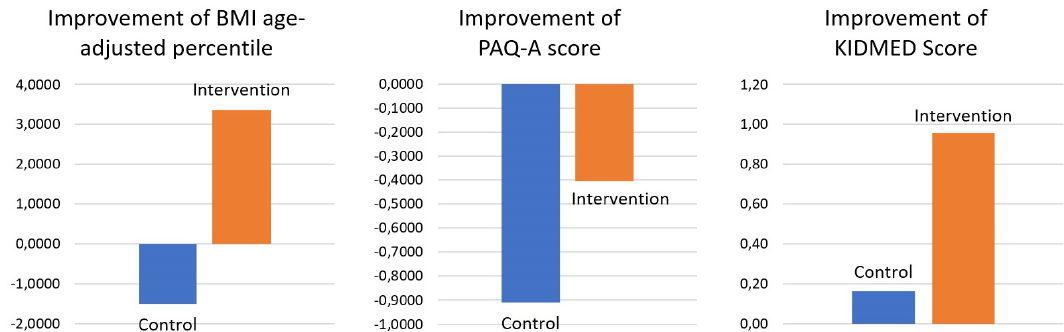
Figure 1. Estimated marginal means for the alteration of BMI age-adjusted percentile, PAQ-A score and KIDMED score in intervention and control groups for the model including